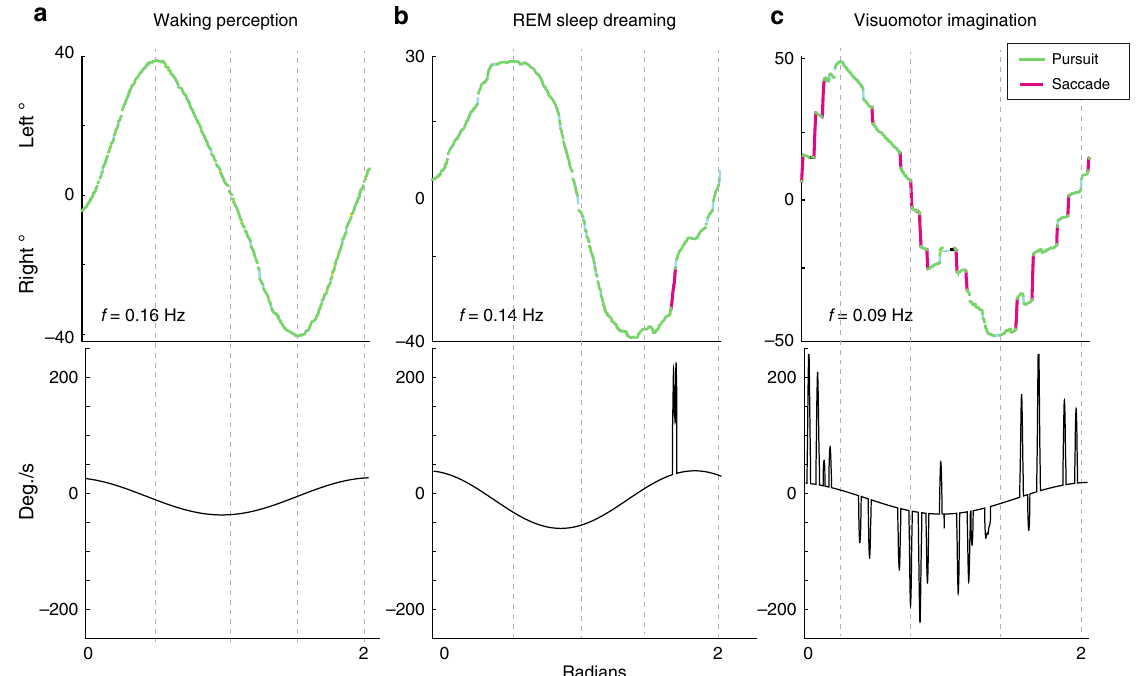
Fig. 2 Classi fi cation of 1D horizontal meridian tracking for a single participant. Eye-tracking is shown during a waking perception, b lucid REM sleep dreaming and c visuomotor imagination conditions. Slow tracking during imagination showed intrusions of saccadic eye movements during the tracking movement, while waking perception and REM sleep dreaming showed predominately smooth pursuit eye movements. Bottom panels show velocity (degrees/s) as the derivative of the best- fi t sine function plus